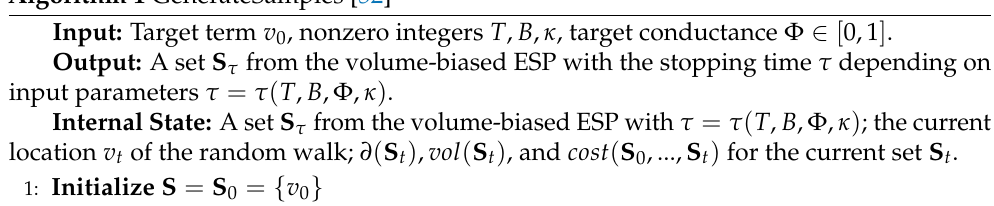
Algorithm 1 GenerateSamples